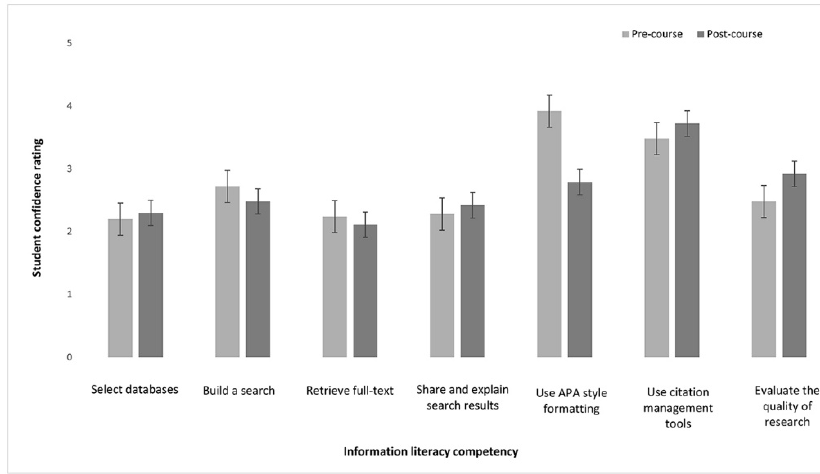
Figure 1 Student confidence ratings in executing information literacy practices before and after completing an evidence-based practice (EBP) course